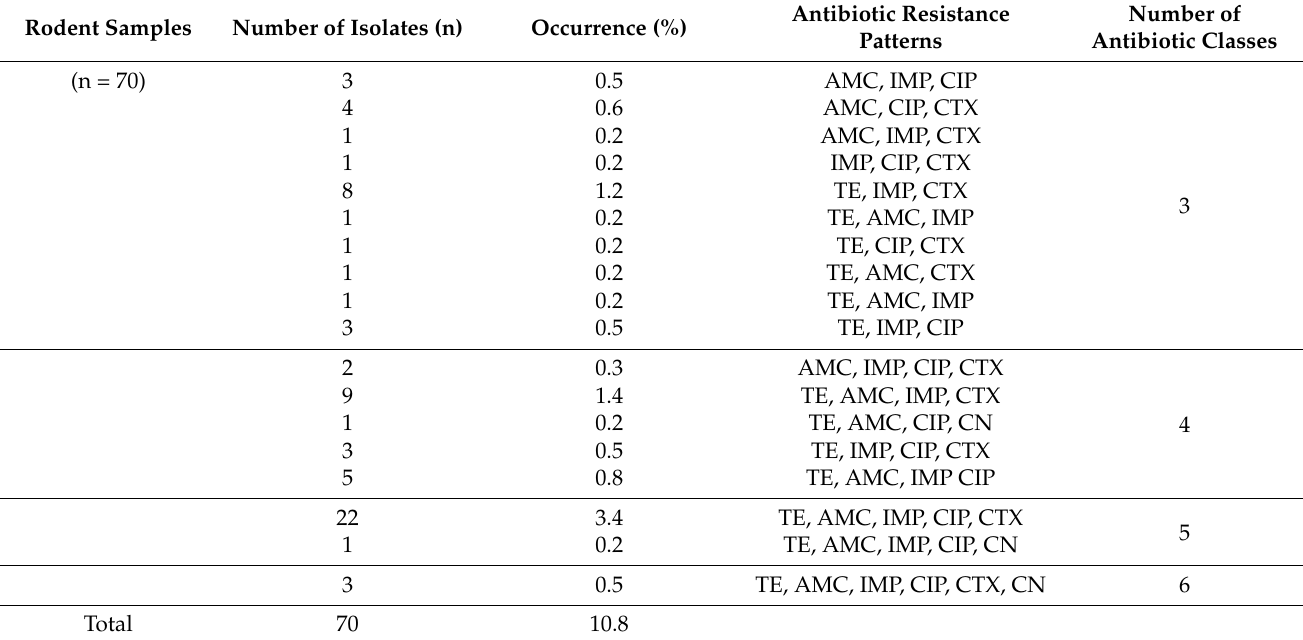
Table 6. Resistance patterns of 70 MDR E. coli isolates from rodent samples.